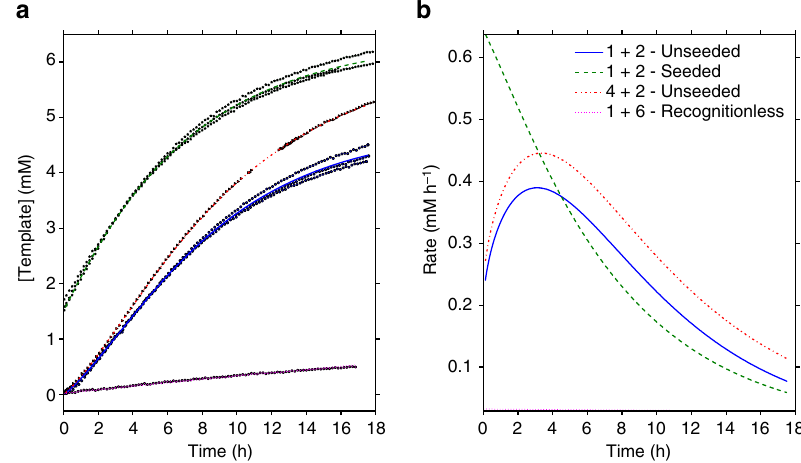
Fig. 3 Kinetics of self-replication reaction. a Concentration vs. time pro fi les for the reaction of 1 and 2 in CDCl 3 , with ( green ) and without ( blue ) seeding with 3 . Also shown are the reactions of unmodi fi ed amine 4 with 2 to form 5 ( red ) and of 1 with 6 ( magenta ). All data points obtained over three repeats are plotted along with the model fi t, and error analysis for reactions of 1 and 2 is included in Supplementary Figs. 3 and 4. b First derivatives of the model fi ts shown in a to give the rate of reaction vs. time for each case